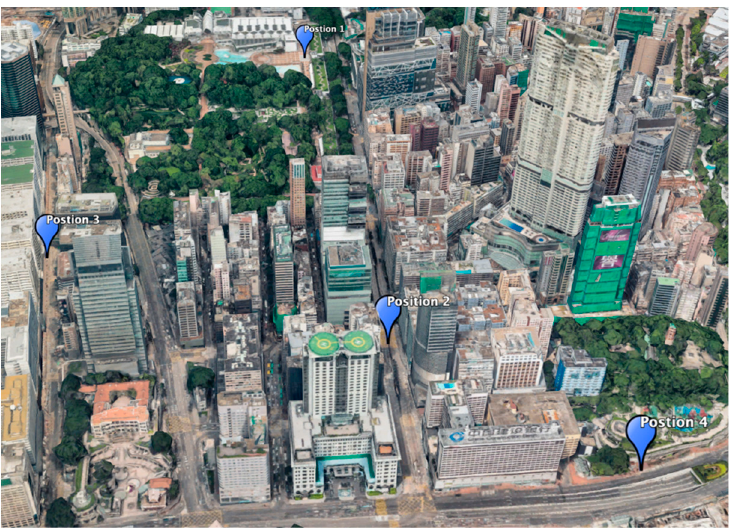
Figure 3. Experiment locations.